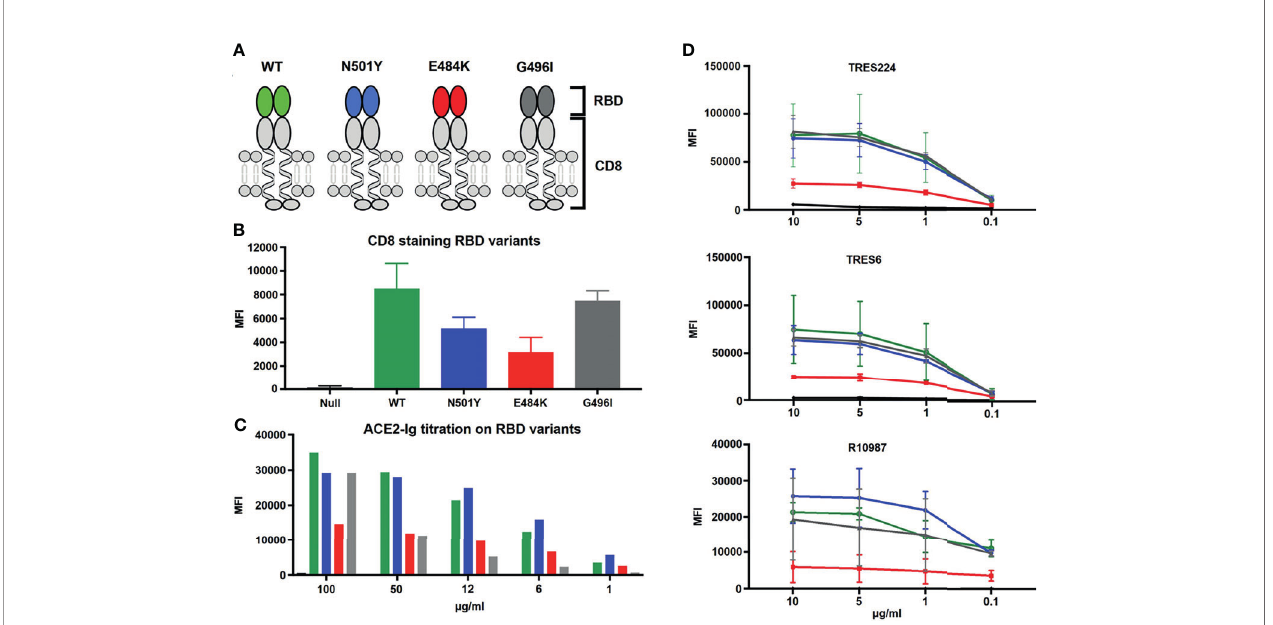
FIGURE 6 | In fl uence of single amino acid exchange mutation in the RBD of the S protein on the expression and binding activity of the chimeric RBD-CD8 protein. (A) Schematic drawing of the RBD-CD8 protein with either an WT (green), or an N501Y (blue), E484K (red) or G496I (grey) mutated RBD sequence. (B) Flow cytometric analysis of the expression of the RBD-CD8 protein on Ramos cells stained with anti-mouse CD8 antibodies. (C) Titration of the ACE2-Ig binding to the four indicated Ramos cell populations. (D) Titration of mAb TRES224, TRES6 and R10987 binding to Ramos cells carrying the indicated RBD-CD8 proteins. As negative control we used non-transfected Ramos cells (black). The mean values of three different experiments are